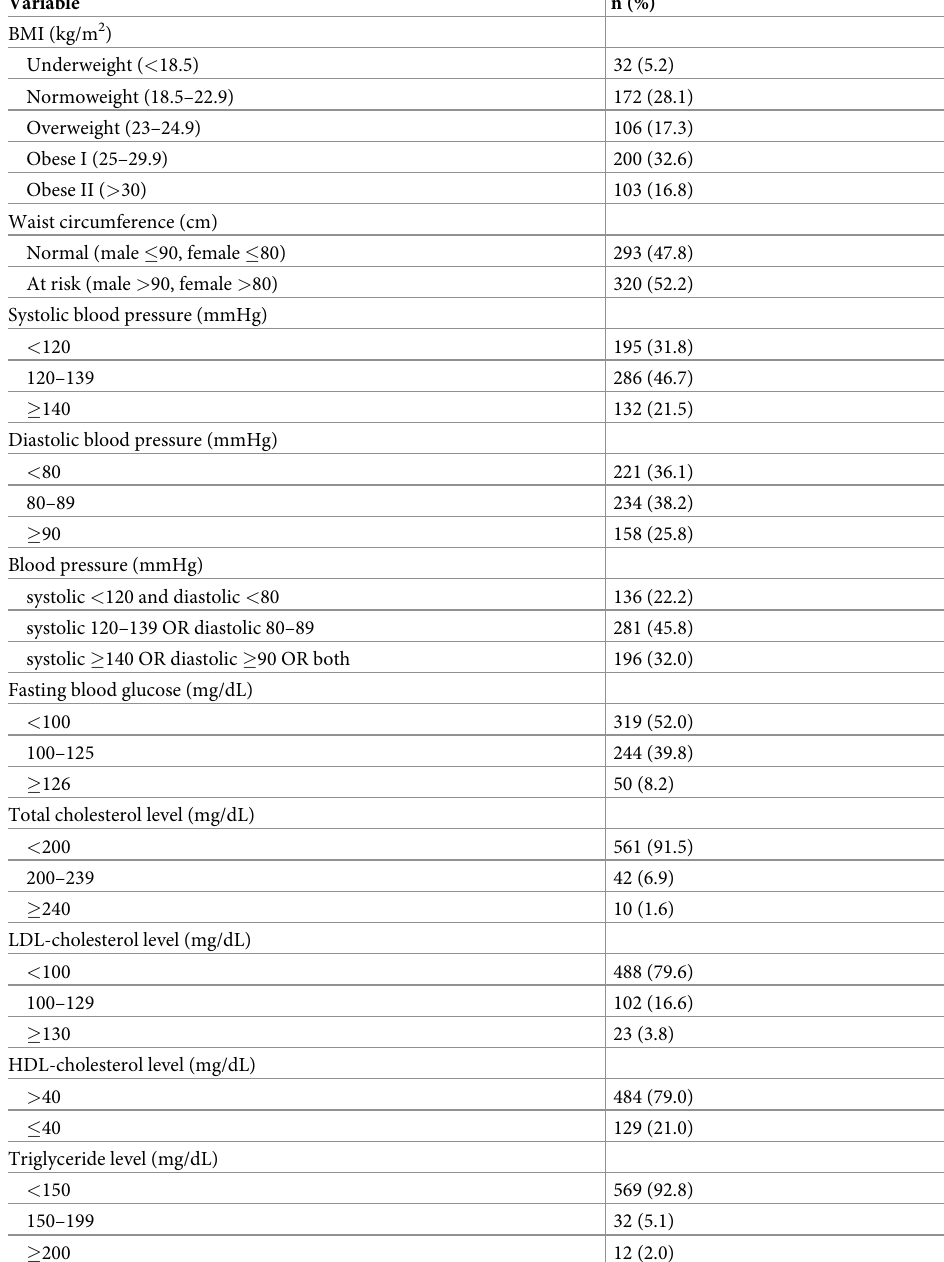
Table 3. Biological risk factors for noncommunicable diseases among university employees ( n = 613).